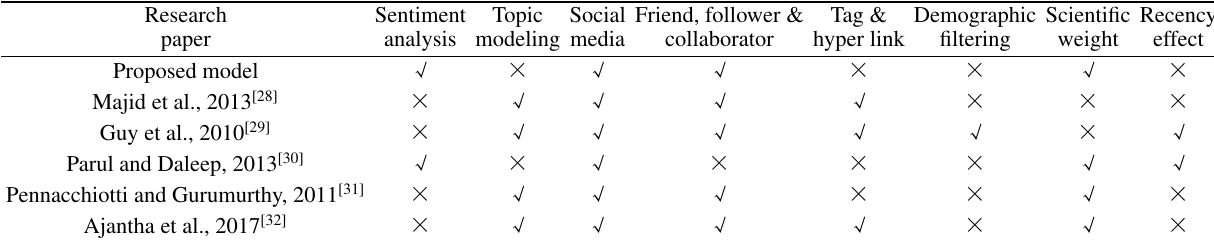
Table 4 Personalized recommendation based on social media